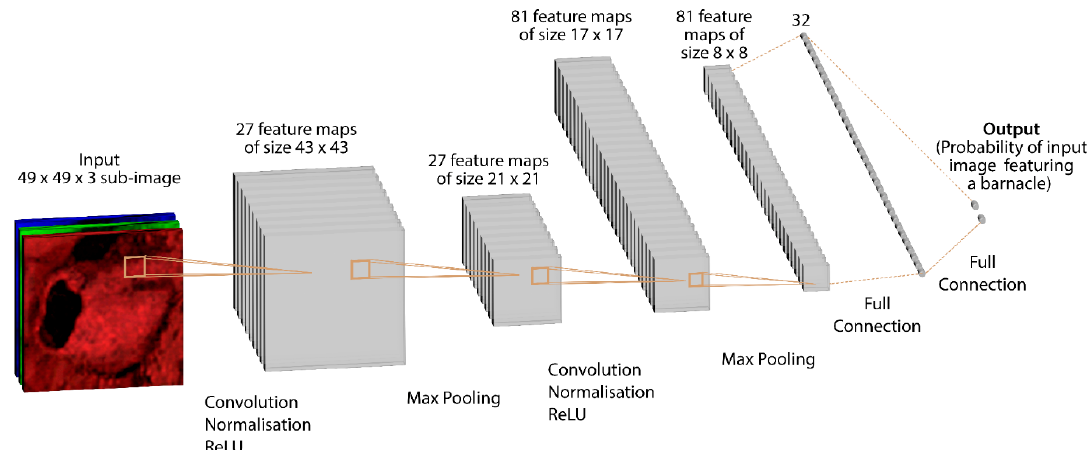
Figure 8. Network Architecture of the two convolutional neural network (CNN) models considered for training barnacle fouling on ship hull in a virtual environment.